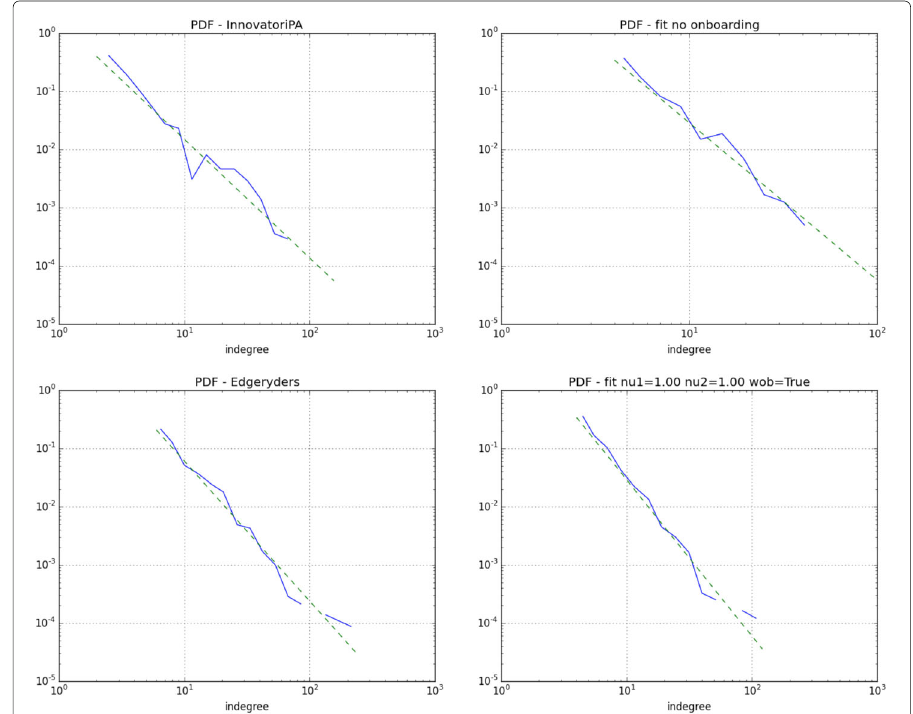
Fig. 3 (log - log) Probability density function from the transformed degree distributions. ( topleft ) The Innovatori PA network without onboarding policy in place versus ( topright ) a simulated network with preferential attachment and no onboarding. ( bottomleft ) The Edgeryders network with onboarding and preferential attachment versus ( bottomright ) a simulated network with preferential attachment and fully effective onboarding ( ν 1 = ν 2 =